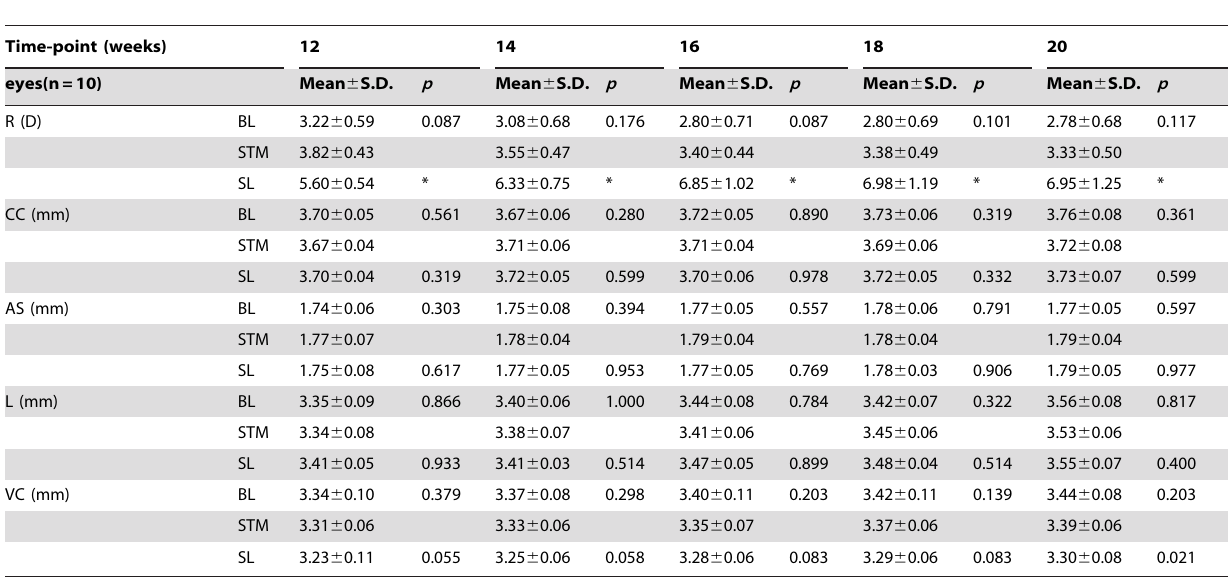
Table 4. Mean biometric results from guinea pigs reared in the three groups and the comparisons between the SL or BL and the STM groups at each time point from 12 to 20